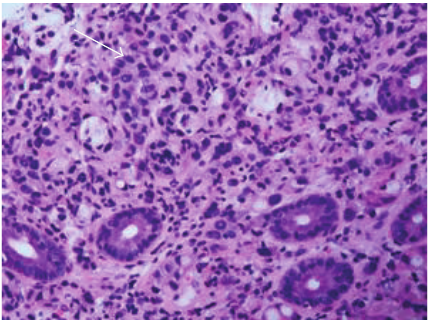
Figure 5: (H&E, 20x) Duodenal mass biopsy showing tumor cells in an infiltrative pattern interspersed within intestinal mucosa. The cells are hyperchromatic and pleomorphic and show abortive gland formation (arrow) consistent with poorly differentiated adenocarci-